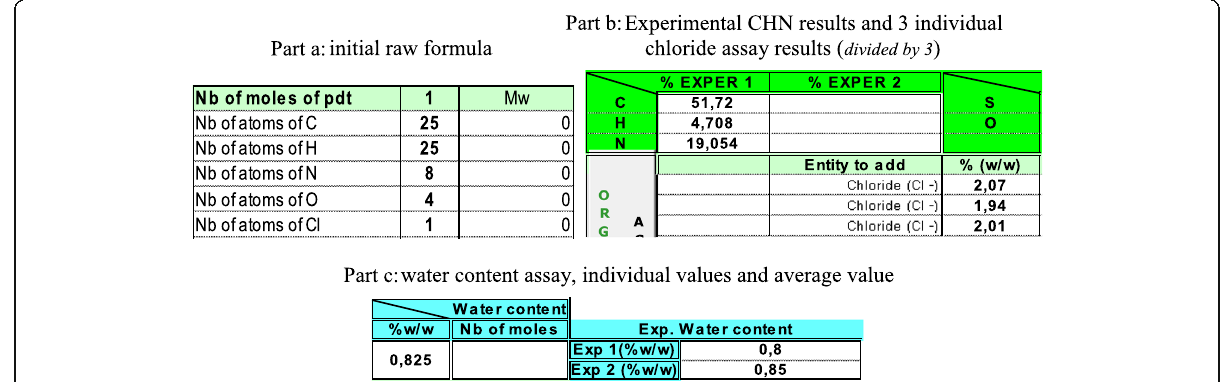
Fig. 5 User interface screenshots (parts a, b, and c) –– first set of experimental results, except those related to the impurity profile, inserted in Mat-CHN for the compound C 25 H 25 N 8 O 4 Cl,